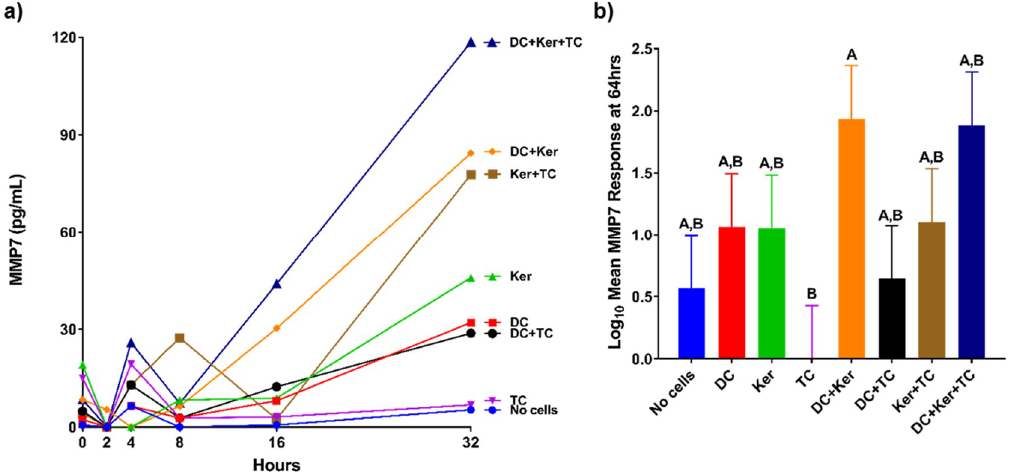
Figure 3. ( a ) MMP7 responses of single cell and co-cultures when treated with HagB ( n = 3). HagB was added at Time 0 to single-cell cultures and co-cultures of T-cells (TC), GE keratinocytes (Ker), and dendritic cells (DC). MMP7 concentrations were determined at 0, 2, 4, 8, 16, and 32 h. The MMP7 responses from the HagB diluent were subtracted from the HagB-induced MMP7 responses. ( b ) MMP7 responses to HagB at 64 h ( n = 9). The MMP7 responses from the HagB diluent were subtracted from the HagB-induced MMP7 responses. A two-way fixed effect ANOVA was fit to log-transformed concentrations of MMP7. Pairwise group comparisons were conducted using the post-hoc Tukey’s honest significance test. A 0.05 level was used determine statistically significant differences between groups. Shared letters above bars indicate the groups are not statistically different from one another ( p > 0.05), while differing letters indicate significantly different mean values ( p < 0.05).